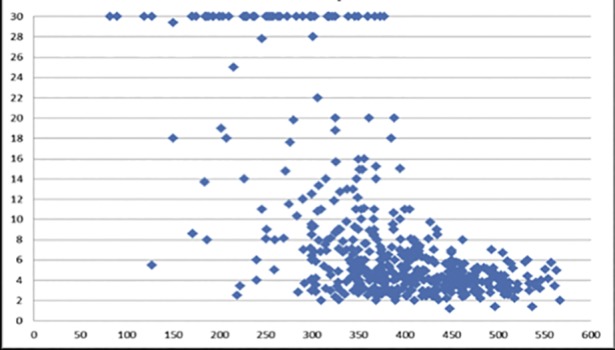
Individual details of TRF scores (in seconds) and 6MWT results (in meters).